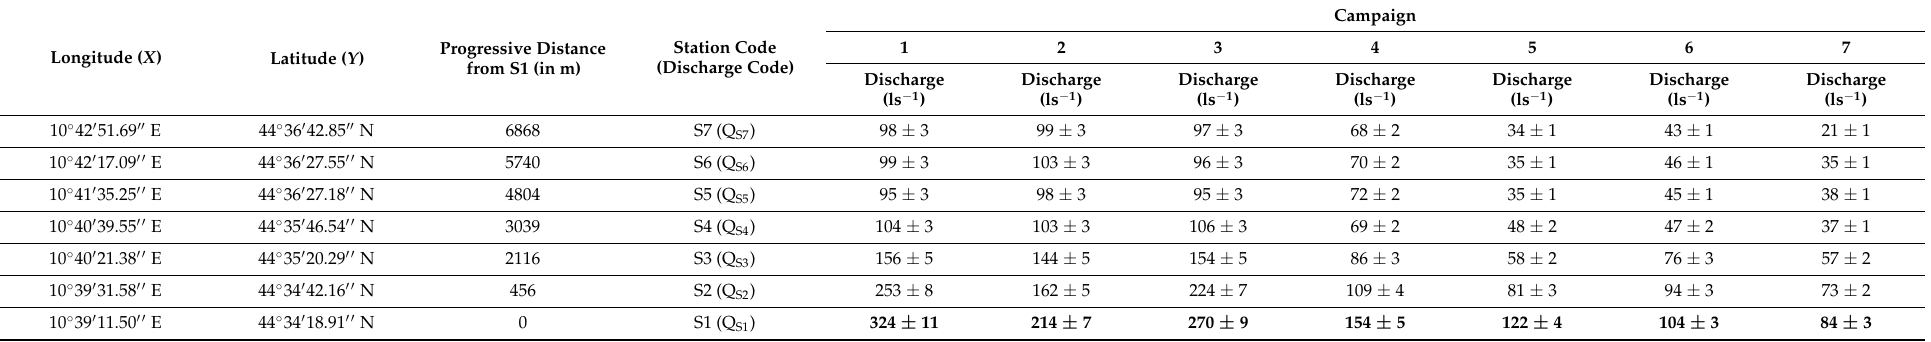
Table 2. Discharges (in ls − 1 along with the corresponding uncertainties calculated as ± 2 σ ) as result of the salt injection tests. Amount of salt used for preparing hyperconcentrated solutions were always 200 gl − 1 in 5 L of water. Values used as x -axis for obtaining regression line in Figure 5 are highlighted in bold. Campaign 1 Station Code Longitude ( X ) Latitude ( Y ) Progressive Distance (Discharge Code) from S1 (in m)